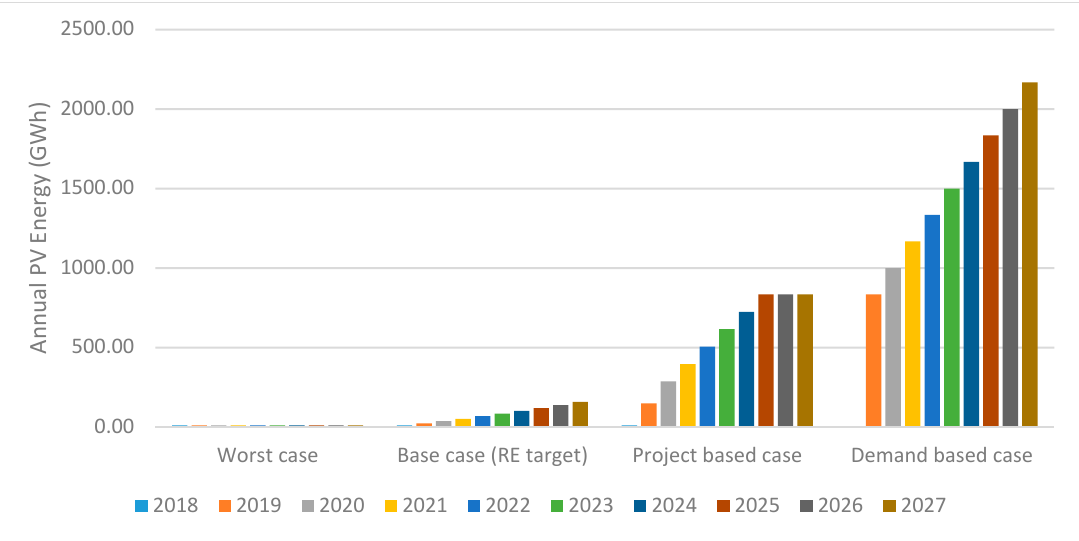
Figure 9. Forecast of annual PV electricity generation according to the 4 scenarios.